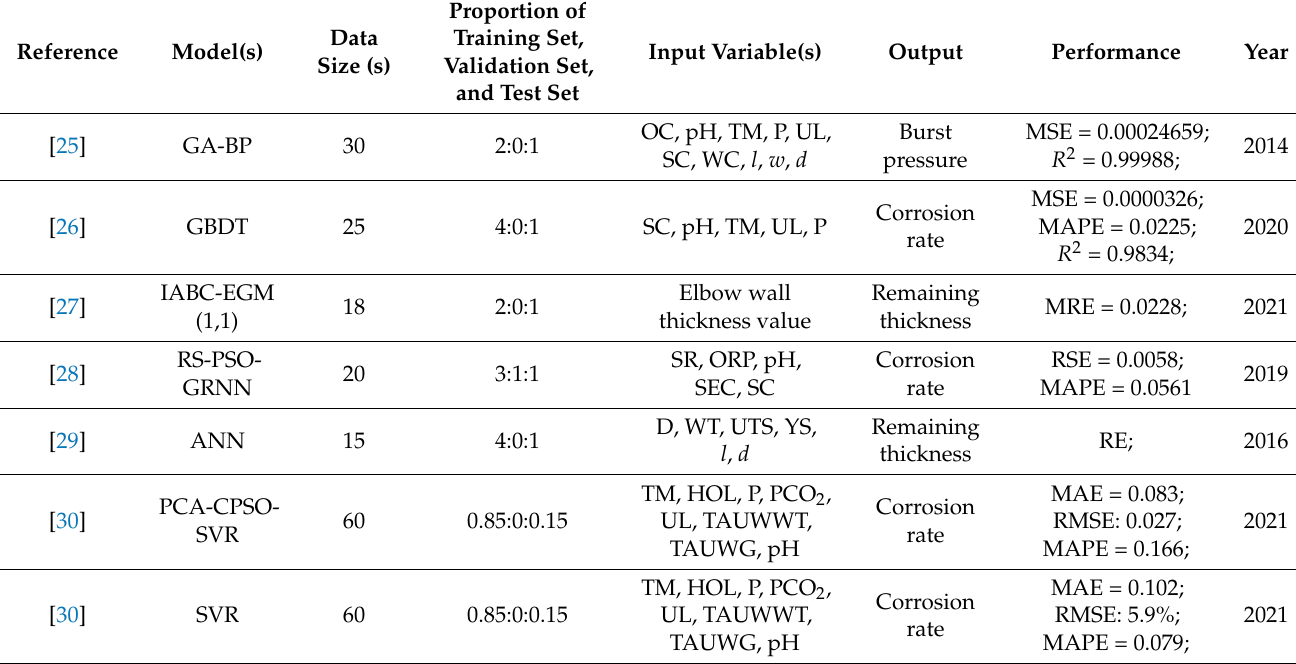
Table 5. 71 intelligent prediction